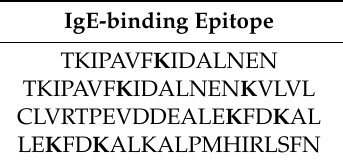
Table 5. β -lactoglobulin IgE-binding epitopes reported in literature [26] that have lactosylation sites (highlighted in